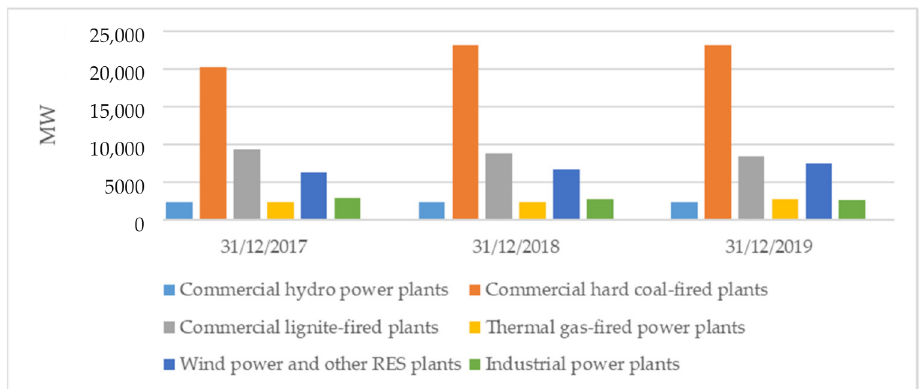
Figure 1. Structure of the Polish Power System’s installed capacity in 2017–2019 [MW]. Source: developed by the authors, based on Reference